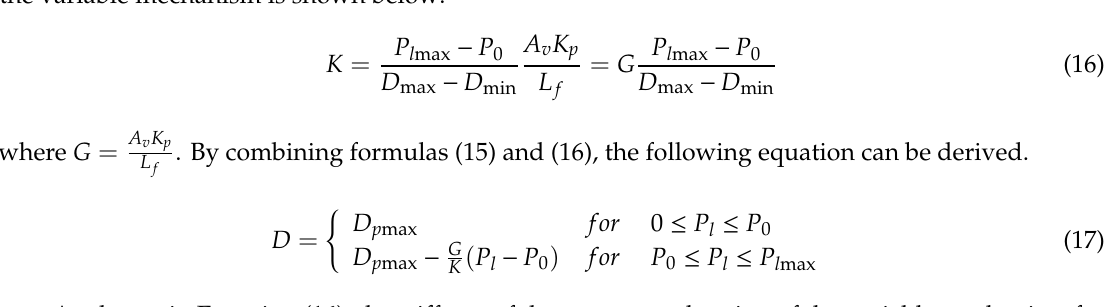
Figure 6. Relationship between displacement and load pressure for DLS-EHA.